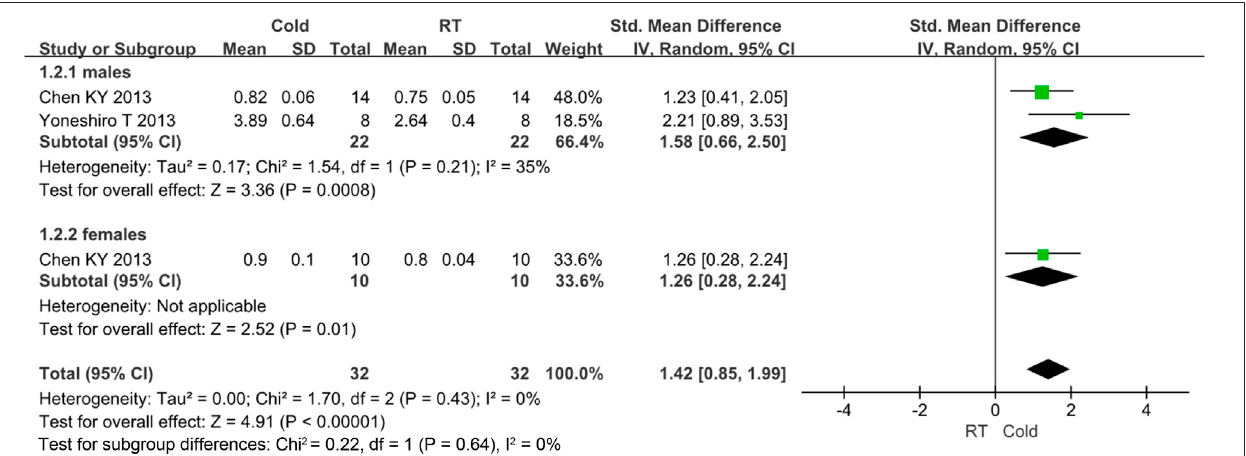
FIGURE 7 | Forest plot for the brown adipose tissue activity of subgroup analysis.